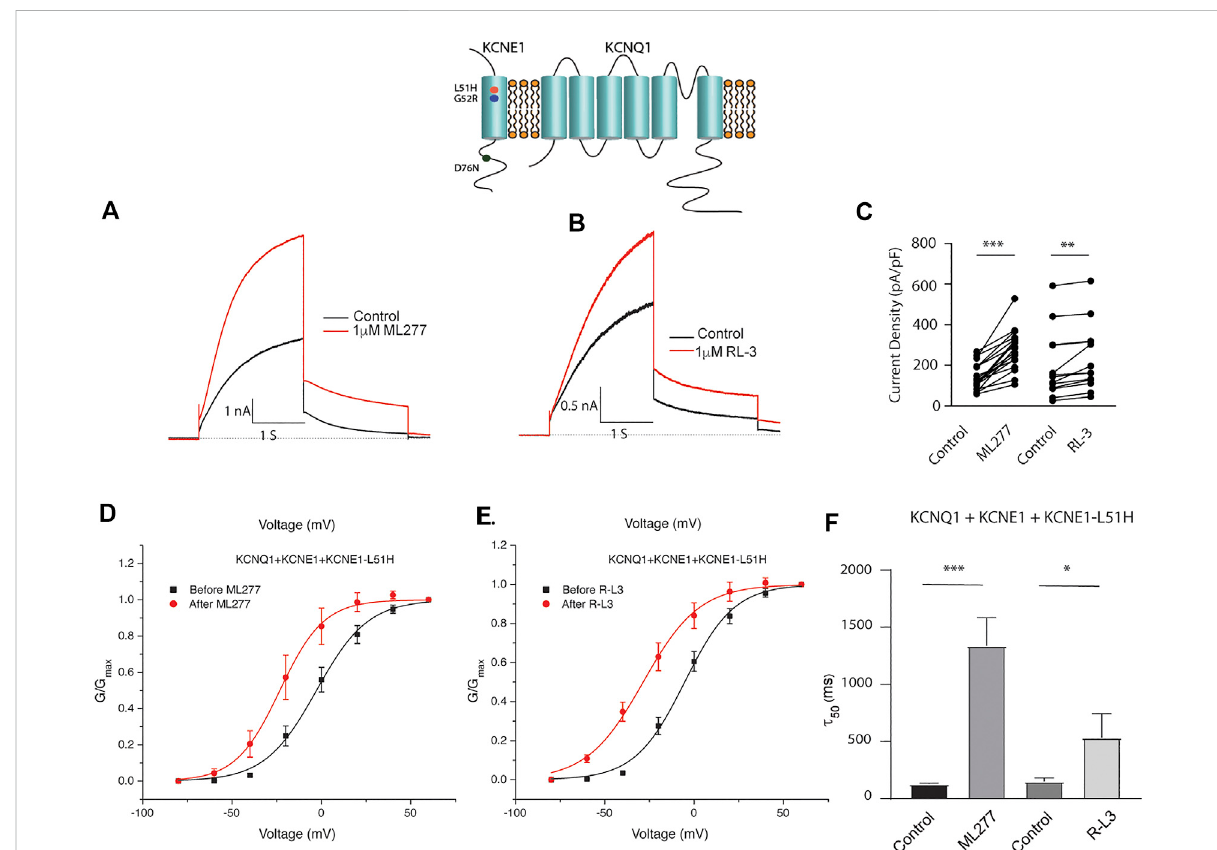
FIGURE 6 Heterozygous KCNQ1- L51H mutant channel activity is potentiated by ML277 and R-L3. Cells were transfected with KCNQ1/KCNE1/KCNE1- L51H and exposed to 1 μ M ML277 (A) and 1 μ M R-L3 (B) . Transfections were carried out with KCNQ1 and KCNE1 WT and KCNE1 mutant ratios of 1: 0.5:0.5 as described in thetext. Currents recorded at+60 mV are shown before (black traces) and after (red traces) exposureto drugs. (C) . Summary data, in which peak currents measured at + 60 mV at 2 s in the absence and presence of drugs are connected by straight lines. (D) . Normalized conductance/voltage curves measured in the absence (black) and presence (red) of 1 μ M ML 277. (E) . Normalized conductance/voltage curves measured in the absence (black) and presence (red) of RL-3. (F) . Summary of slow deactivation time constant ( τ 50) in the absence and presence of 1 μ M of both drugs. ML277: n = 14; R-L3: n =